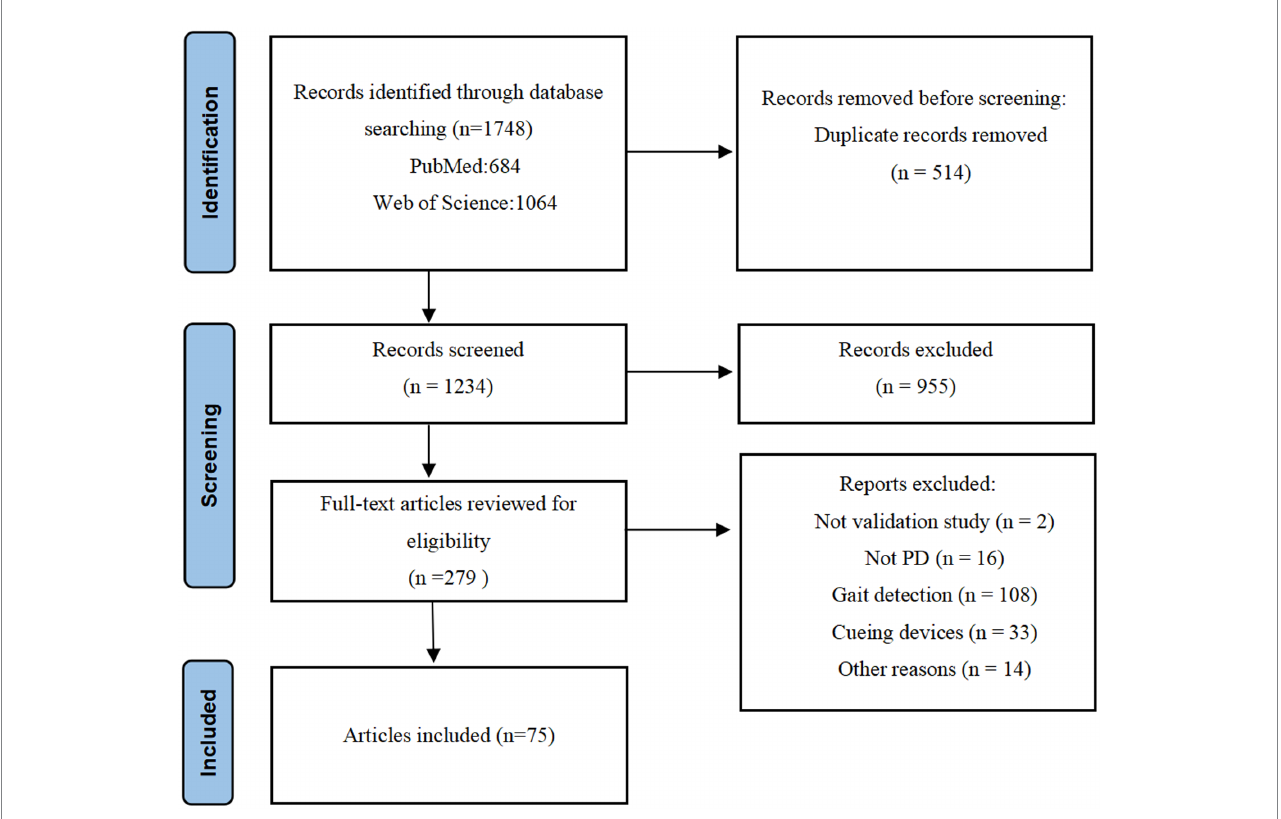
FIGURE 1 Study flow